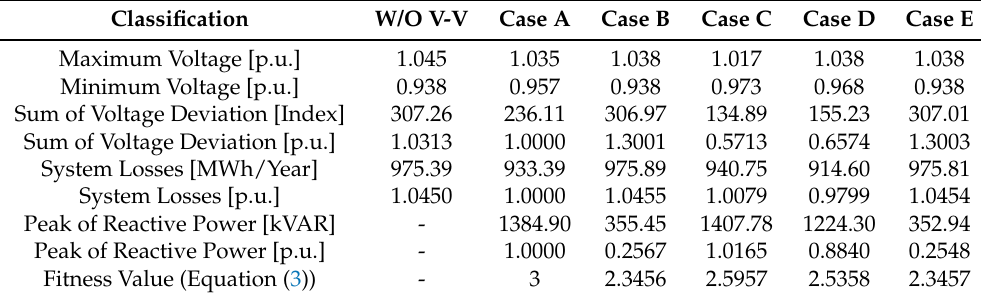
Table 4. Simulation